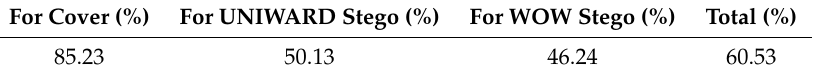
Figure 9. Combining two binary classifiers in parallel for the ternary classification. Table 2. Ternary classification rates obtained by simply combining two binary classifiers separately trained for WOW and UNIWARD ( bpp =